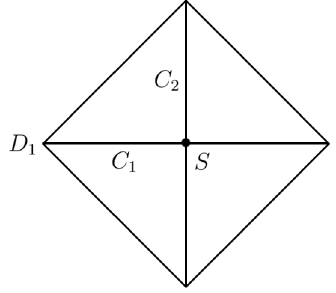
Figure 11 . The toric diagram for F 0